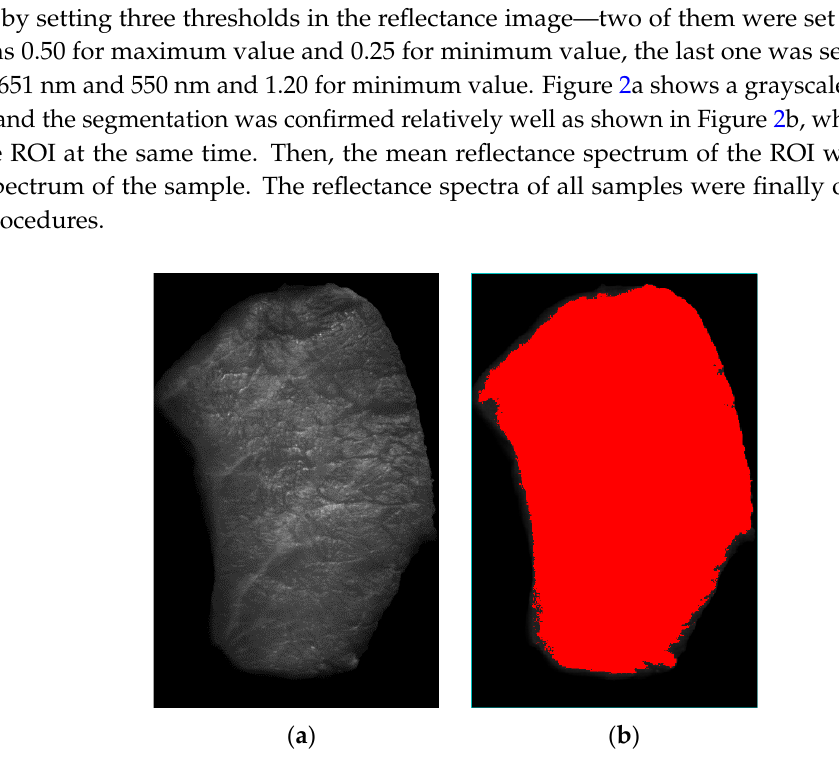
Figure 2. Grayscale image at 651nm and segmentation of ROI of meat sample: ( a ) Grayscale image at band 651 nm; ( b ) Segmentation of ROI. ROI: region of interest.